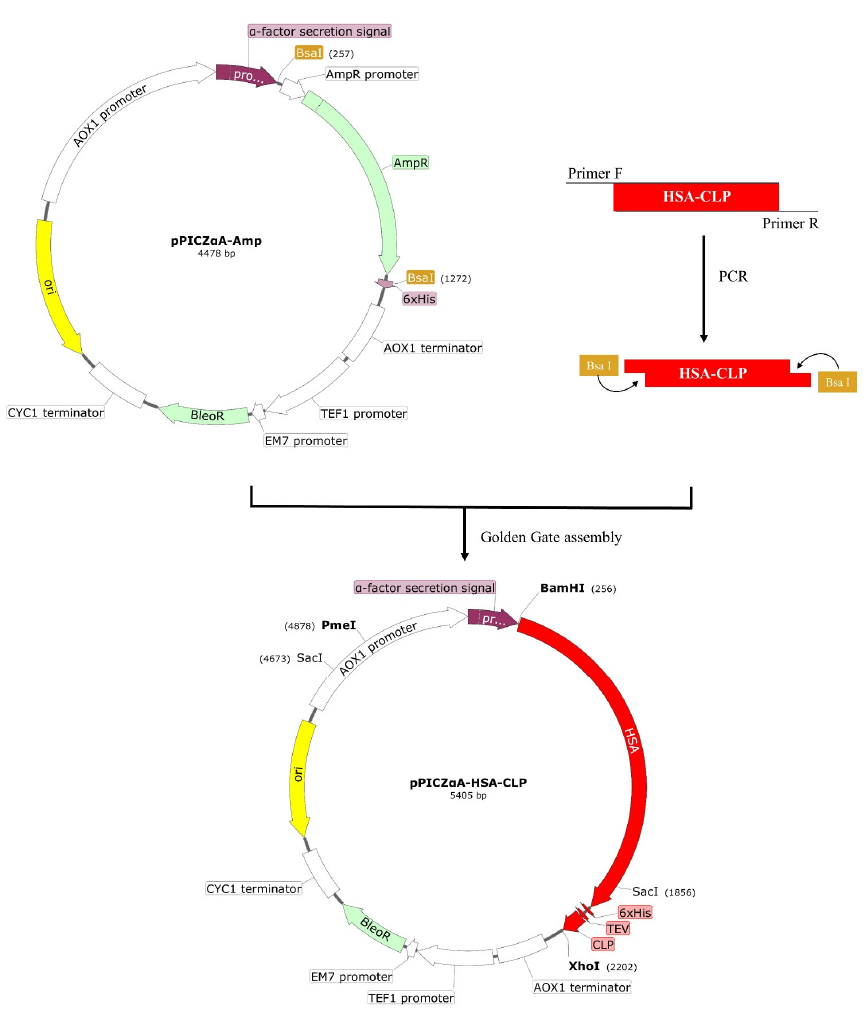
Figure 1. The schematic diagram of the construction expression vector. The target gene was success- fully interested with 6 x His and two restriction sites BamHI and SacI.